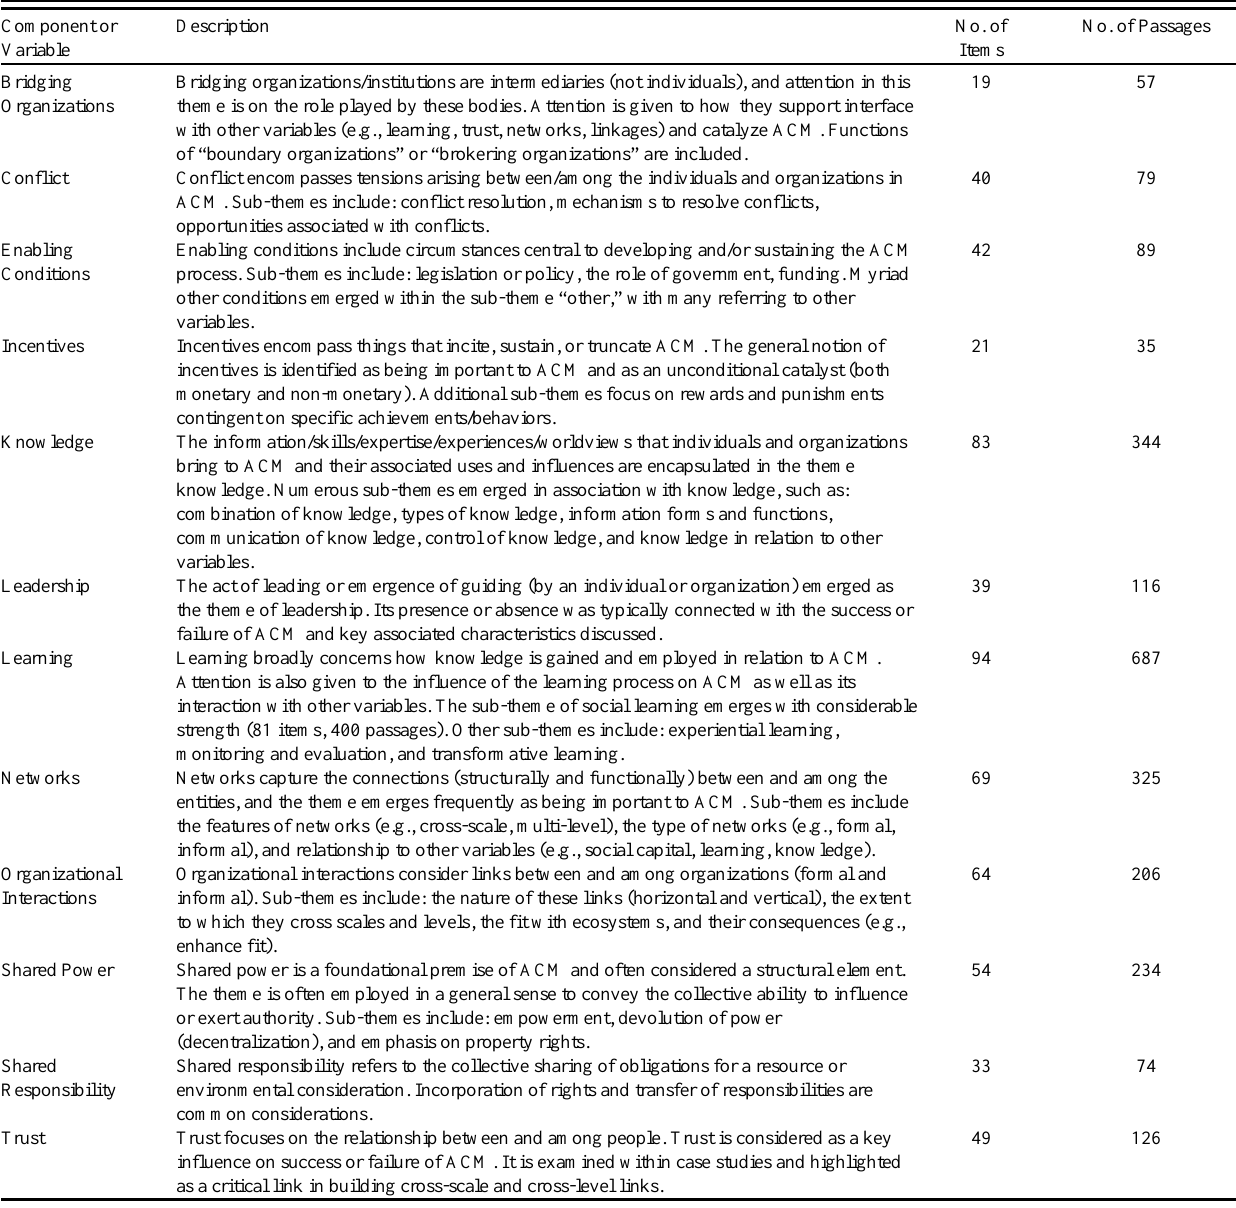
Table 2. Component or variables of interest emerging within adaptive